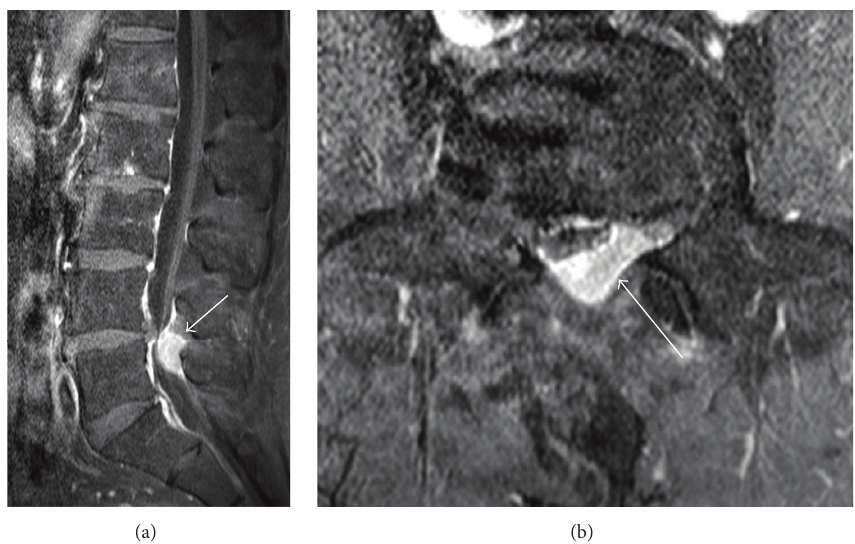
Figure 3: Sagittal (a) and axial (b) gadolinium-enhanced T1-weighted MR images with fat saturation show intense enhancement of solitary spinal epidural mass (arrow).